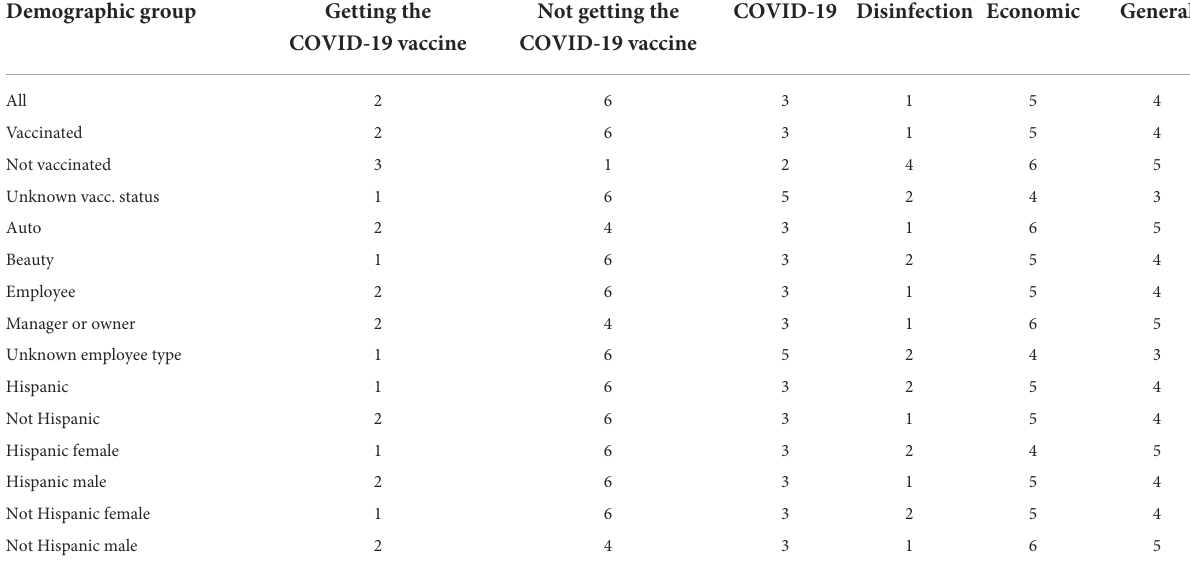
TABLE 4 Perceived risk rankings for various demographic groups, based on the mean perceived risk scores presented in Table A.1 in the Appendix. These rankings range from 1–6 for the six categories listed in the six right-most columns in the table, where 1 is low perceived risk and 6 is high perceived risk relative to the other categories.